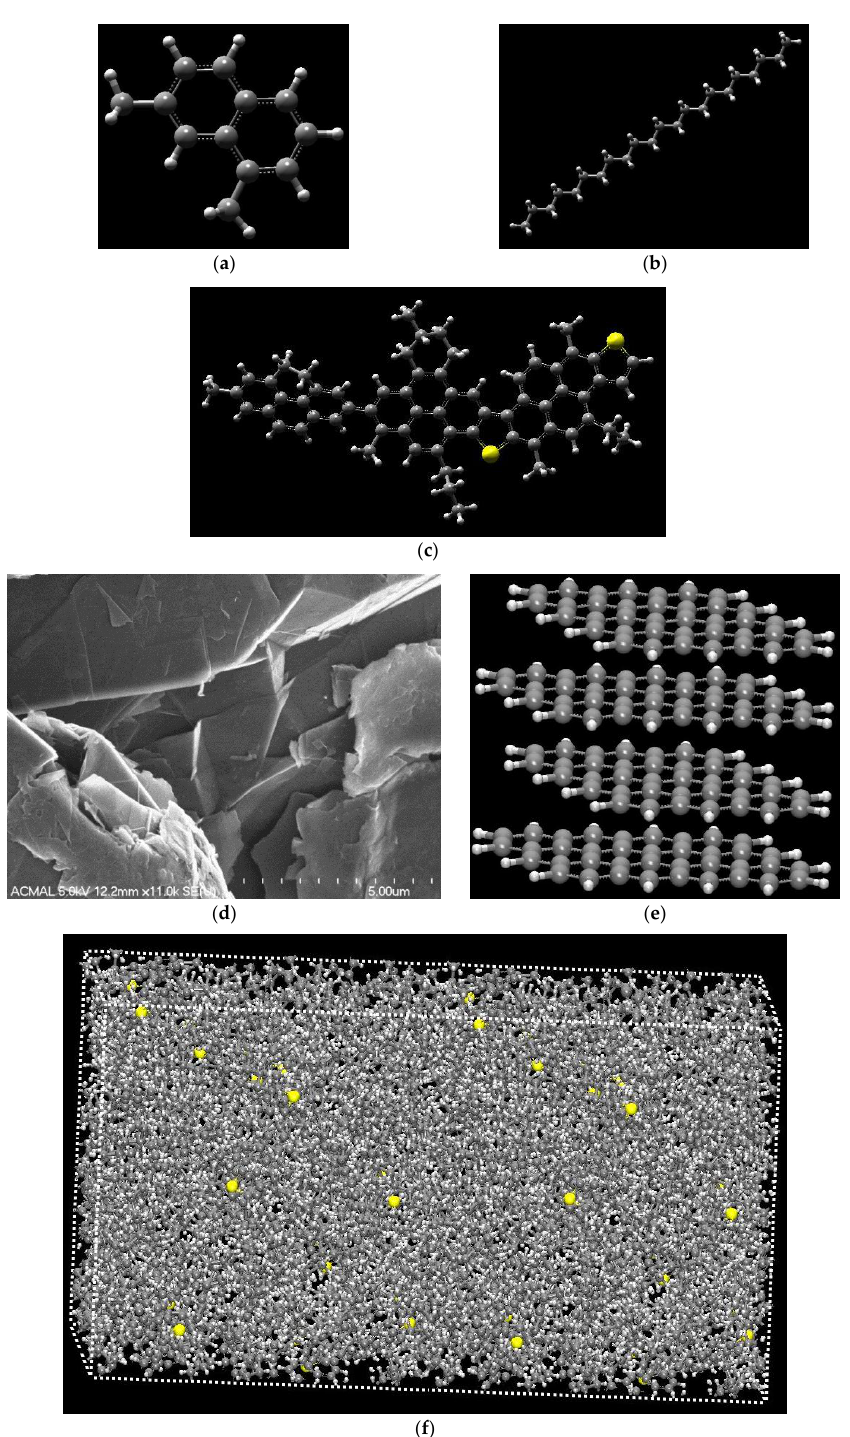
Figure 2. SEM image of multi-layer xGNP particles, structure of multi-layer xGNP model, components of control asphalt model and xGNP modified asphalt model. ( a ) The structure of 1,7-Dimethaylnaphtalene; ( b ) the structure of docosane: white color for hydrogen atom; grey color for carbon atom; ( c ) The structure of asphaltene: white color for hydrogen atom; grey color for carbon atom and yellow color for sulfur atom; ( d ) FE-SEM image of multi-layer xGNP nanoplatelets; ( e ) Multi-layer graphite model: white color for hydrogen atom; grey color for carbon atom; ( f ) Molecular structures of xGNP modified asphalt model: white color for hydrogen atom; grey color for carbon atom and yellow color for sulfur atom.